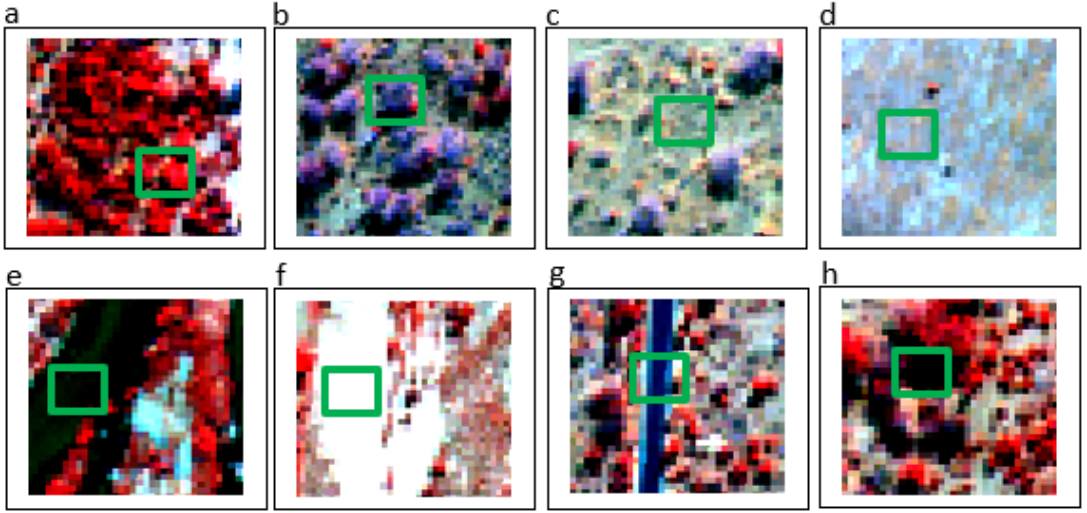
Figure 3. Sample display of land cover types from WorldView-3 satellite image scene (False colour: NIR1, R, G). ( a ) Woody evergreen; ( b ) Woody deciduous; ( c ) Bunch grass; ( d ) Grazing lawn; ( e ) Water body; ( f ) Bare; ( g ) Built-up; ( h )